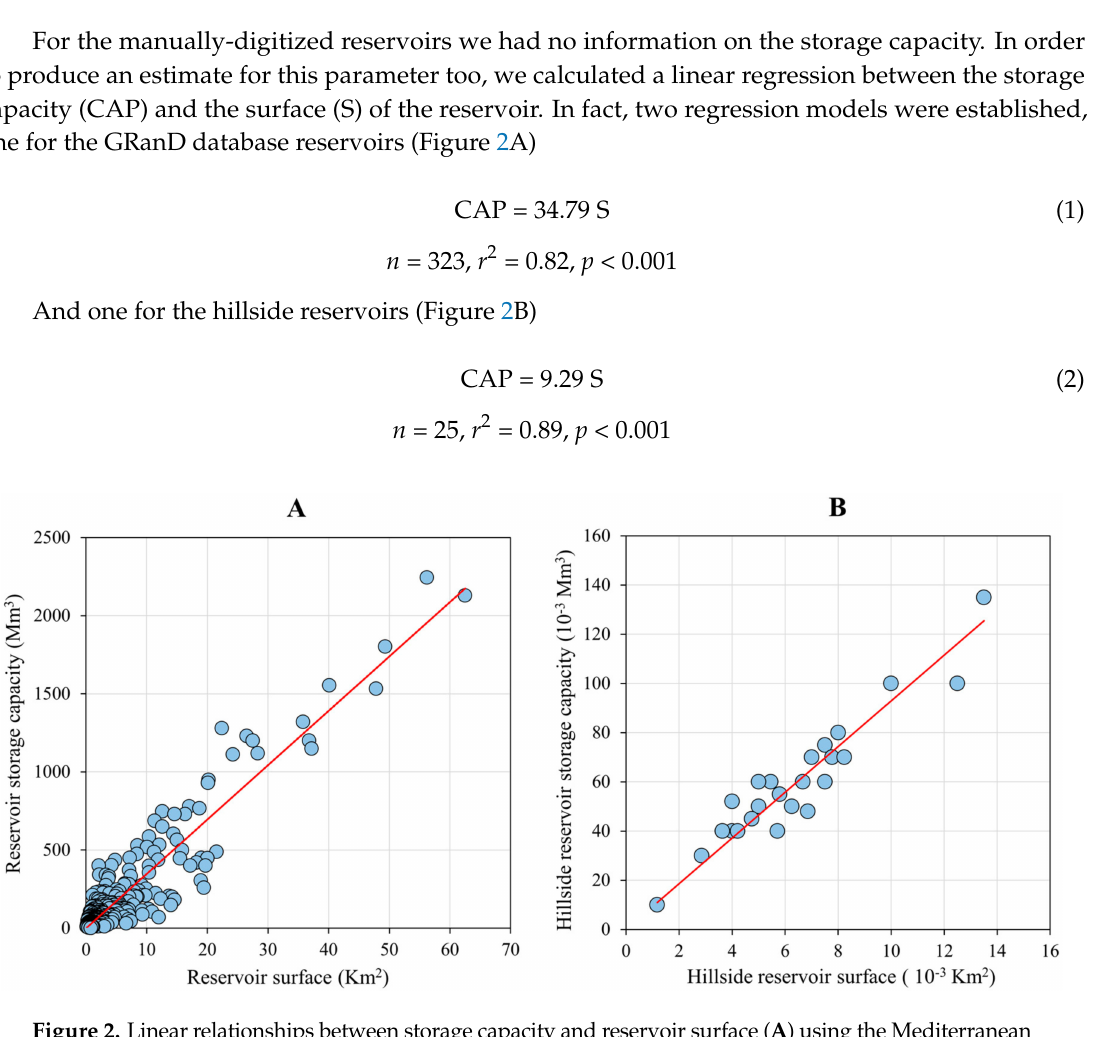
Figure 2. Linear relationships between storage capacity and reservoir surface ( A ) using the Mediterranean reservoirs of the GRanD database [8] and ( B ) using the hillside reservoir database of [39].